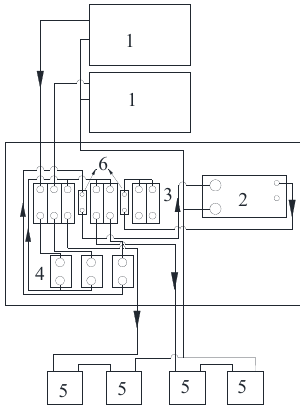
Figure 3. The energy flow of photovoltaic power generation. Table 2. The components according to the Figure 3.